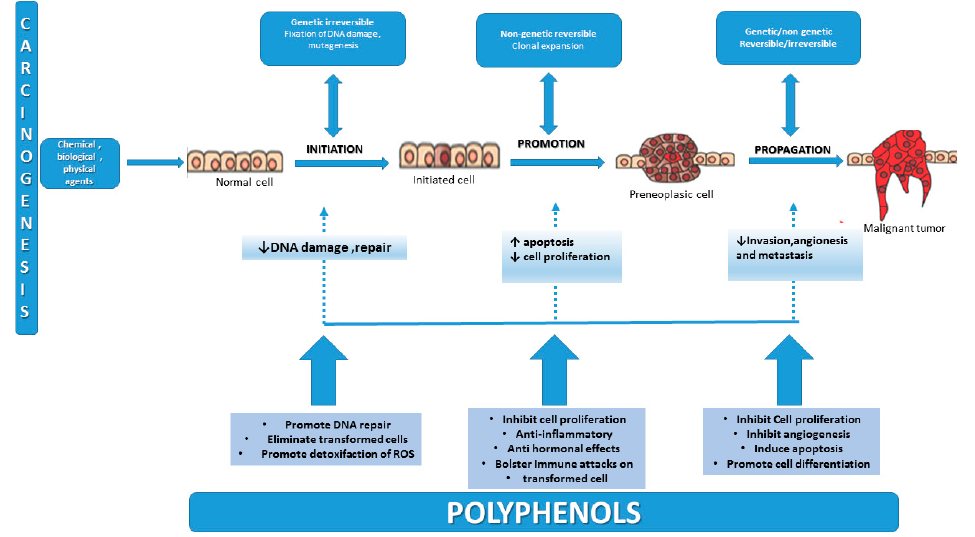
Figure 1. Carcinogenesis—a multifactorial, multi-step process caused by environmental agents—mediated carcinogenesis and steps modulated by chemopreventive polyphenols (adapted after Maru [17] and Kotecha [18]).